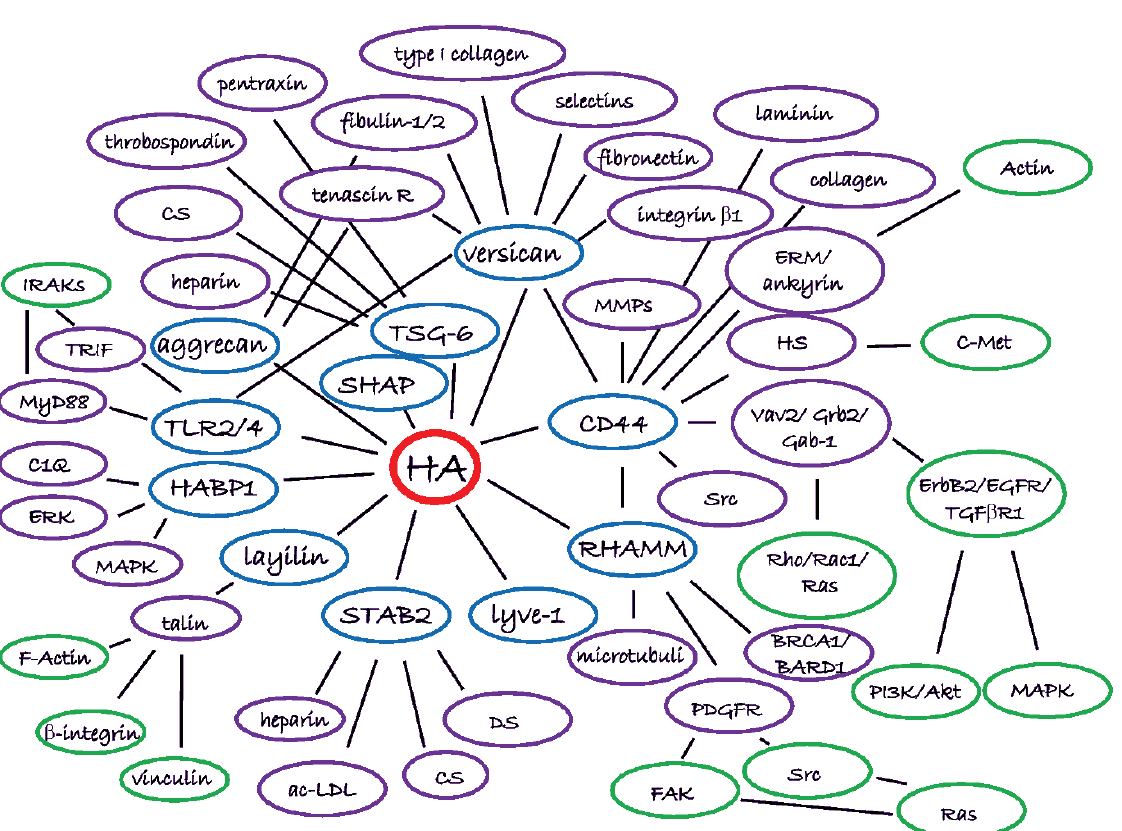
Figure 2. The HA Interactome. HA is produced at the plasma membrane of cancer cells and/or stromal cells by HAS enzymes and is extruded to the extracellular space where it forms a meshwork with its interacting molecules, the hyaladherins, playing multiple complex roles in cell adhesion, motility and proliferation. This diagram emphasizes interactions between HA and its binding molecules, and downstream secondary and tertiary interactions. Although shown as a single interactome in this figure, the indicated interactions might be cell type- and